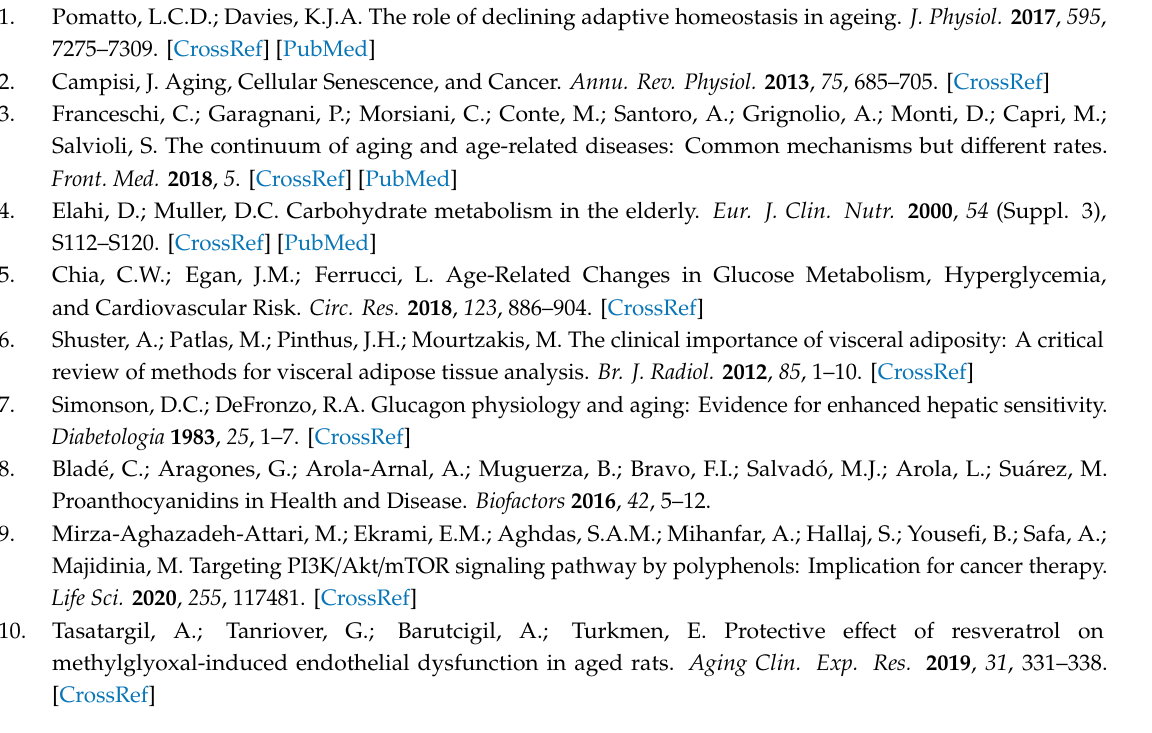
Table S1: Number, weight and classification of tumor per